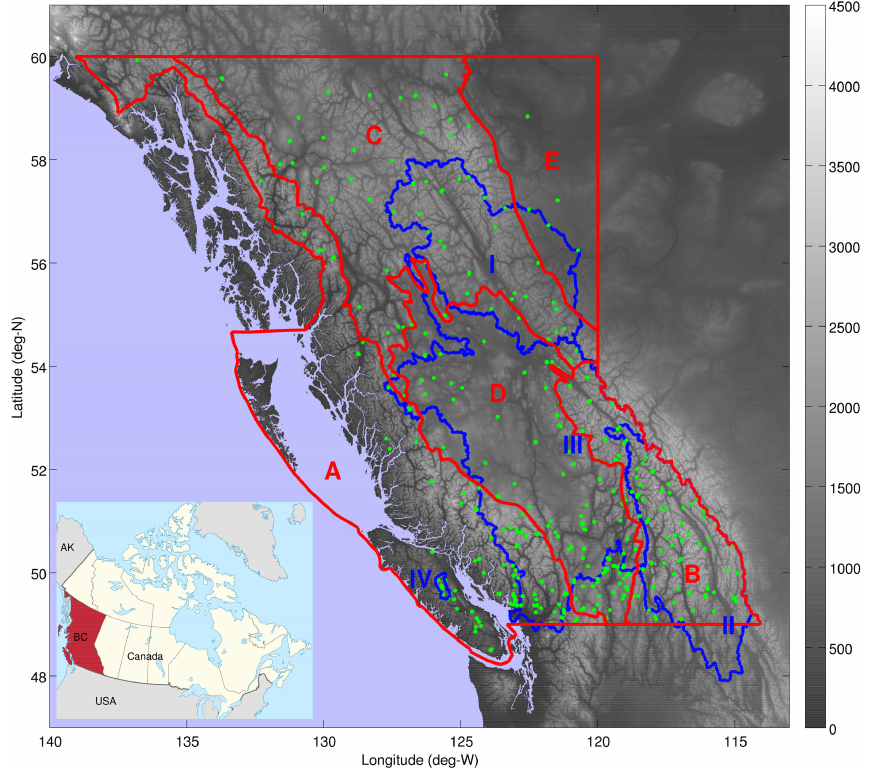
Figure 1. Physiographic regions of British Columbia, Canada, overlaid on the GLOBE 1km DEM. Elevations are shown according to the leg- end with units of meters above sea level. The five physiographic regions are outlined in red: (A) Coast Mountains and Islands, (B) Columbia Mountains and Southern Rockies, (C) Northern and Central Plateaus and Mountains, (D) Interior Plateau, and (E) BC Plains. SWE accumu- lations generally increase from region A to region E. Outlined in blue is the VIC domain run by the Pacific Climate Impacts Consortium, covering four basins throughout BC: (I) the Peace, (II) upper Columbia, (III) Fraser, and (IV) Campbell River watersheds. Manual snow survey station locations are indicated by green dots. Inset: a map of Canada (source: Wikimedia Commons) shows BC highlighted in red. The province is bordered to the south by the contiguous United States (USA) and to the west by the US state of Alaska